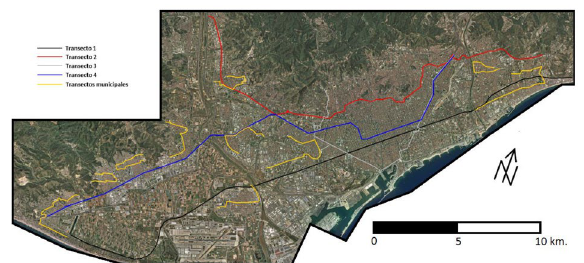
Figure 1. Urban Transects in Barcelona (AMB,